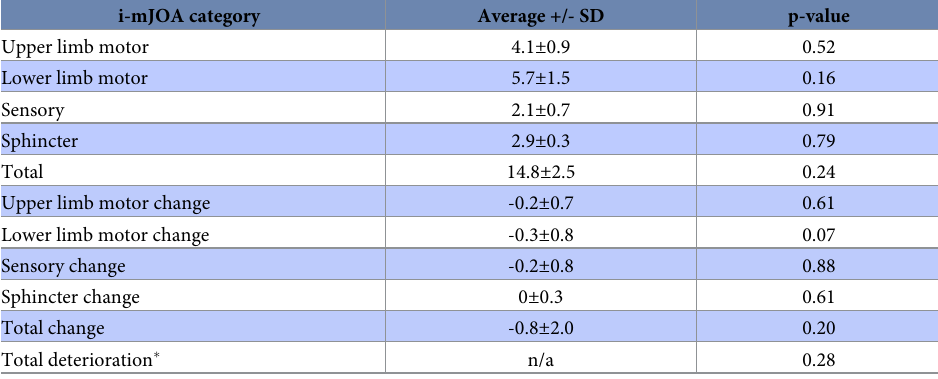
Table 3. The relationships between i-mJOA scores, change in i-mJOA scores, and the decision to operate.